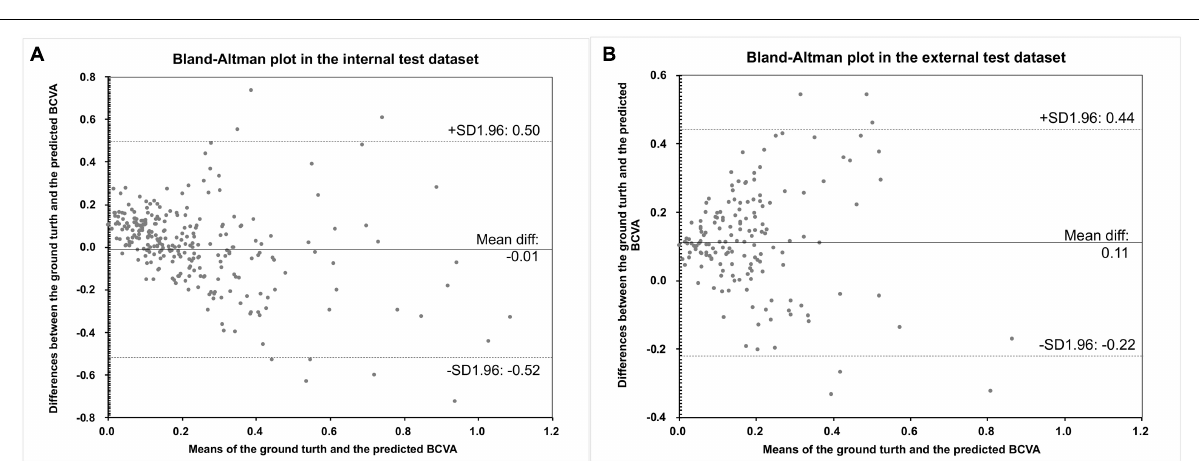
FIGURE 3 | The Bland–Altman plots of the predicted BCVA and the actual BCVA (ground truth) in the internal (A) and external (B) test datasets. All values were provided in logMAR units. BCVA, best corrected distance visual acuity; logMAR, logarithm of the minimum angle of